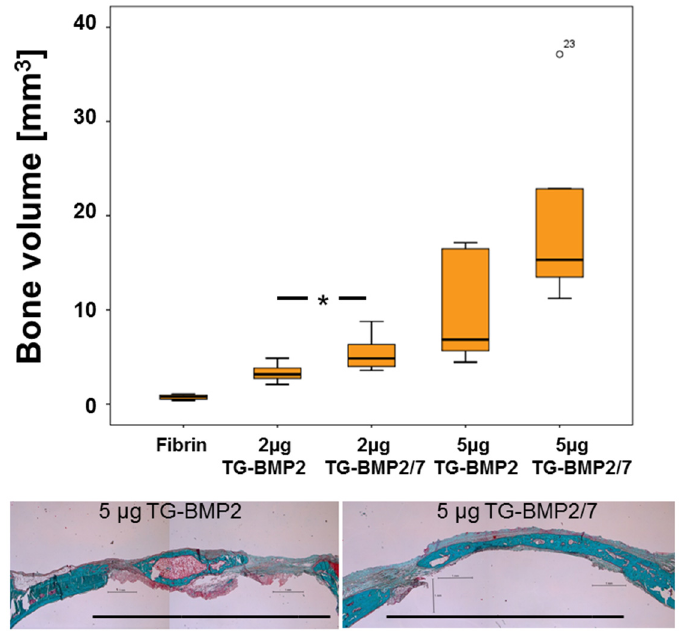
Figure 6. Healing of critical size calvarial defects in the rat. The ability of TG-BMP-2 and TG-BMP-2/BMP-7 in fibrin matrices to promote healing was examined in 8 mm defects in the rat, one per animal (n ≥ 5 for each group). The volume of the defect filled with calcified tissue after 35 days of healing with standard errors is shown along with representative Goldner trichrome stained histological sections of defects treated with 5 µg TG-BMP2 and TG-BMP-2/BMP-7 (lower panel). Original defect margins of 8 mm are indicated by the black bar. Bone is stained in green and osteoid in magenta. * indicates significance with a p < 0.05. ° indicates a data point outside of the boxplot. For both concentrations, the coverage of the defect with bone was significantly higher for TG-BMP-2/BMP-7 than for TG-BMP-2 at the evaluation point of 35 days (Figure 7). Therefore, the heterodimer TG-BMP-2/BMP-7 heals a critical size defect in the calvarial bone of rats more efficiently than the homodimer TG-BMP-2 at the same